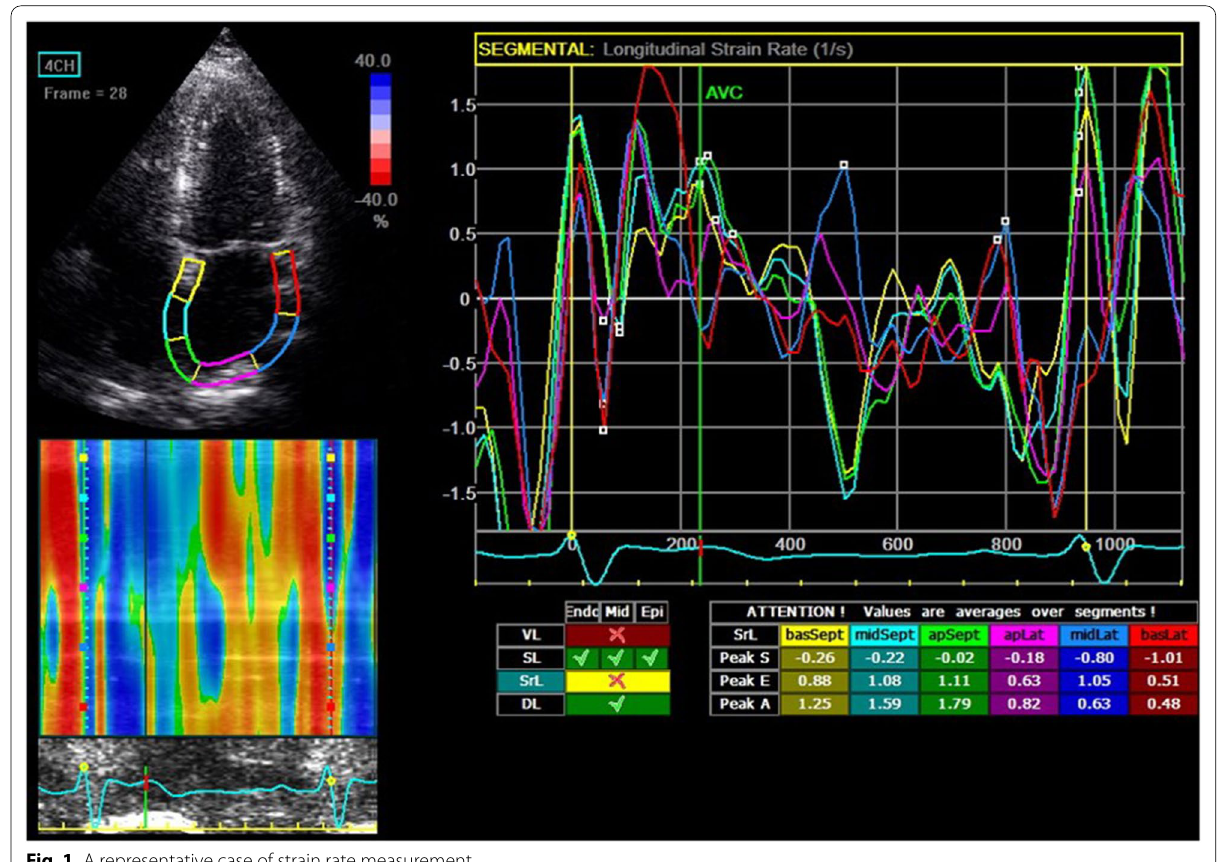
Fig. 1 A representative case of strain rate measurement